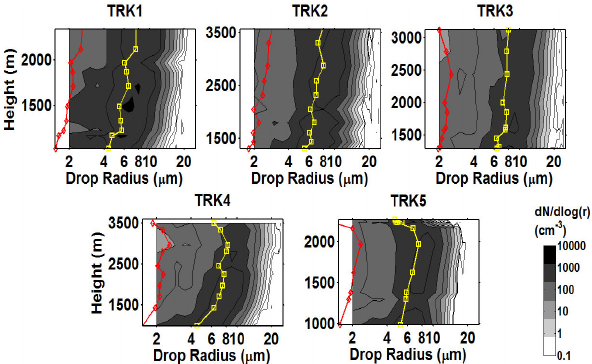
Figure 2. Cloud droplet size distribution as a function of height above the ground. The contours show the distribution (d N/ dlog (D) ). The yellow and red lines represent the average and standard deviation of the radius over the entire measurements, re- spectively. For the purpose of constructing the lines of the average radius and the standard deviation, we divided the measurements into 10 height bins, and for each bin the average was calculated. Note that the vertical axes are not uniform, accounting for the different cloud tops observed in the different flights.